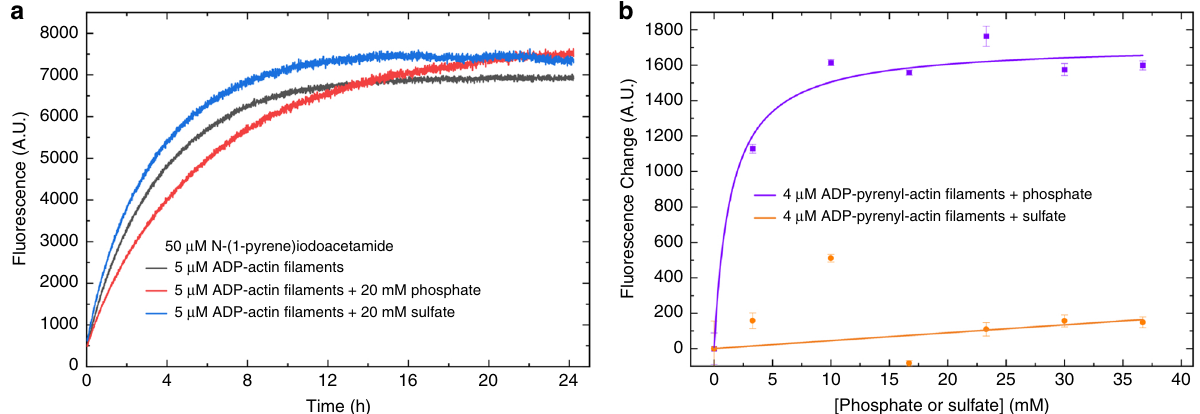
Fig. 4 Interactions between phosphate in the nucleotide-binding site and pyrene. a Phosphate slows the labeling of ADP-actin fi laments with N-(1- pyrene)iodoacetamide. Solutions of Mg-ADP-actin fi laments were polymerized from 5 µ M monomers overnight at 4 °C in 100 mM KCl; 1 mM MgCl 2 ; 10 mM imidazole, pH 7.0; 0.3 mM ADP; 3 mM NaN 3 and preincubated at room temperature with the same volume of either water, 20 mM potassium phosphate or 20 mM potassium sulfate before adding 50 µ M N-(1-pyrene)iodoacetamide. The basal fl uorescence is from the free N-(1-pyrene) iodoacetamide, and the fl uorescence increase is due to the conjugation of N-(1-pyrene)iodoacetamide to the sidechain of C374 in actin fi laments. b Effect of phosphate in the buffer on the fl uorescence of Mg-ADP-pyrenyl-actin fi laments. The fl uorescence change in each data point was calculated by subtracting the fl uorescence of 120 µ L of Mg-ADP-pyrenyl-actin fi laments (polymerized from 5 µ M monomers) preincubated with 30 µ L of water from the fl uorescence of 120 µ L of Mg-ADP-pyrenyl-actin fi laments (polymerized from 5 µ M monomers) preincubated with the same volume of phosphate or sulfate. Each sample was incubated for ~1 hour before the measurements. Error bars indicate the standard deviations of fi ve readings on the same sample. The Y-axes are in arbitrary units (A.U.). Data are presented as mean values + / − SD. Source data are provided as a Source Data fi le.